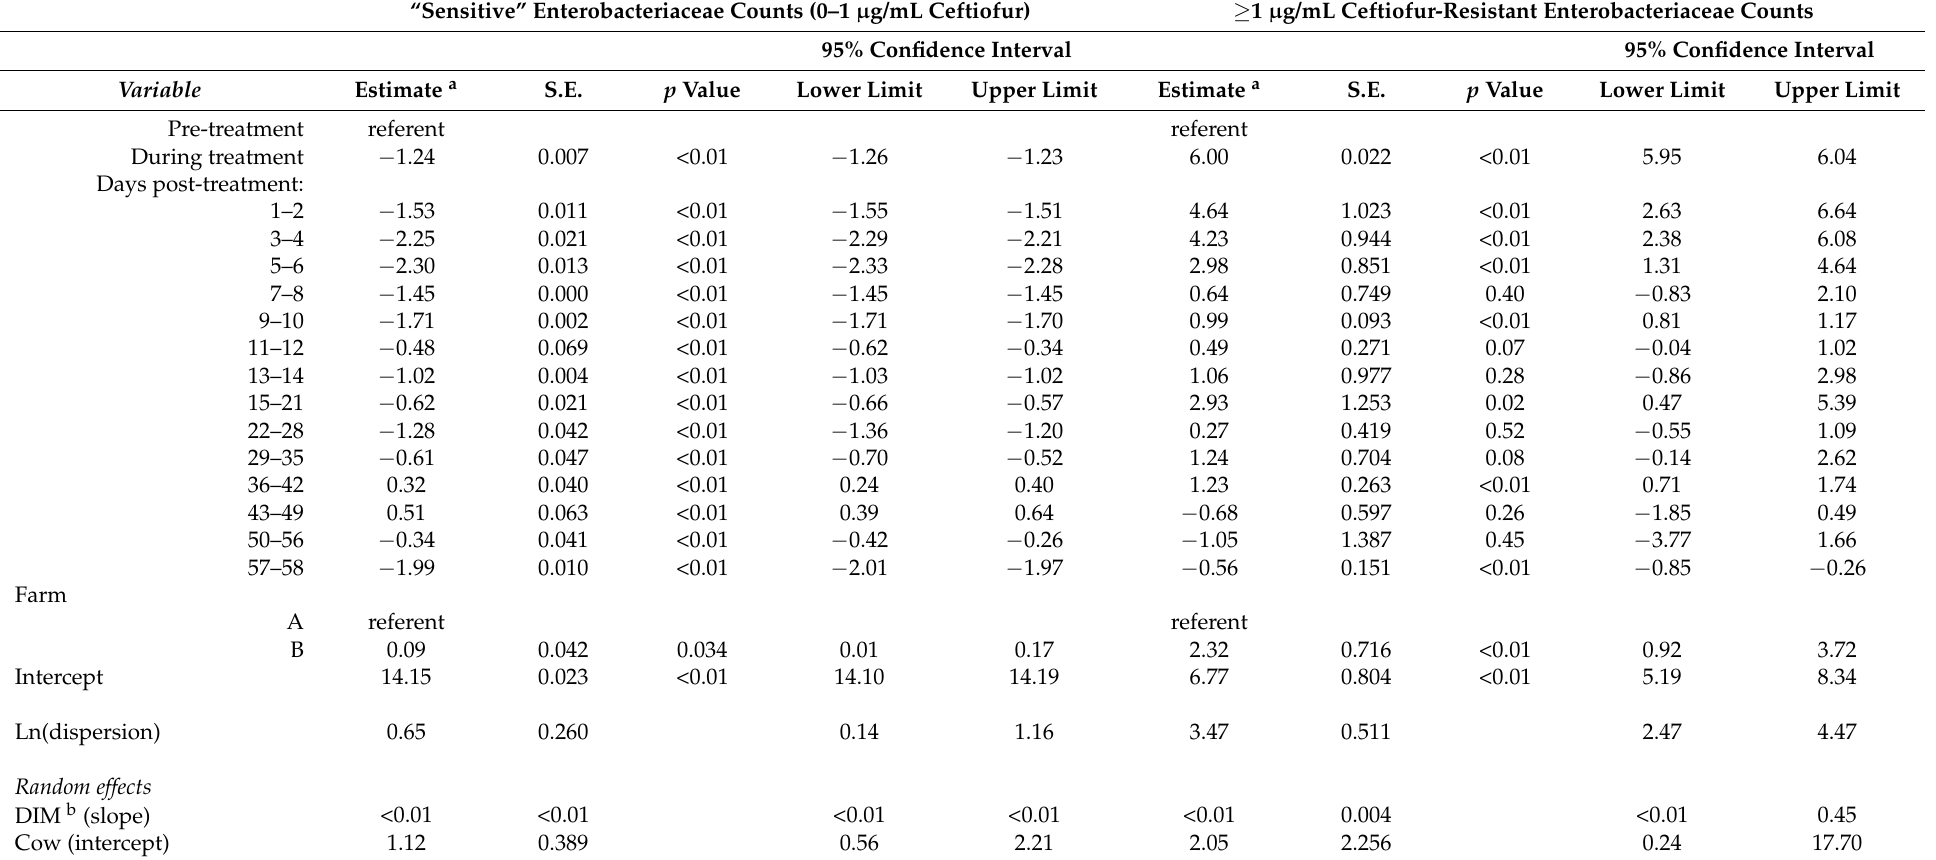
Table 3. Multilevel mixed effect negative binomial model estimates for “sensitive” (0–1 µ g/mL ceftiofur) and ≥ 1 µ g/mL ceftiofur-resistant Enterobacteriaceae counts post-systemic antimicrobial drug treatments in 91 cows on two California dairies over two